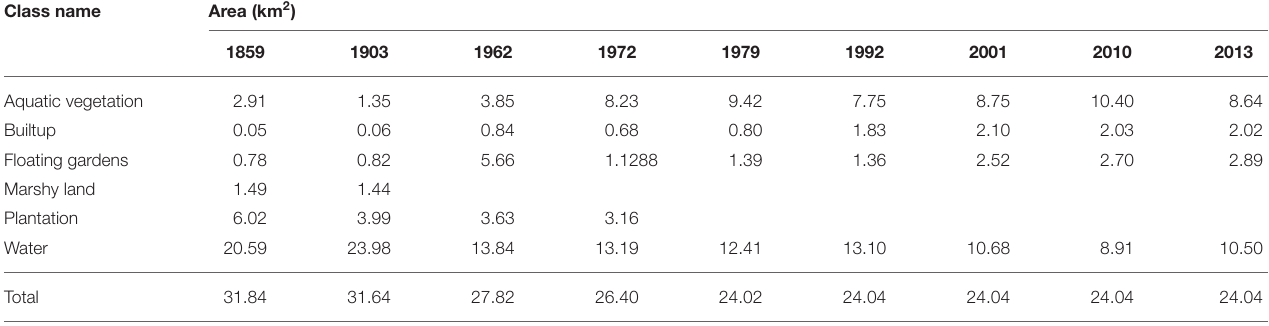
TABLE 3 | Land system changes within Dal lake from 1859 to 2013 (Source: Rashid et al., 2017a).